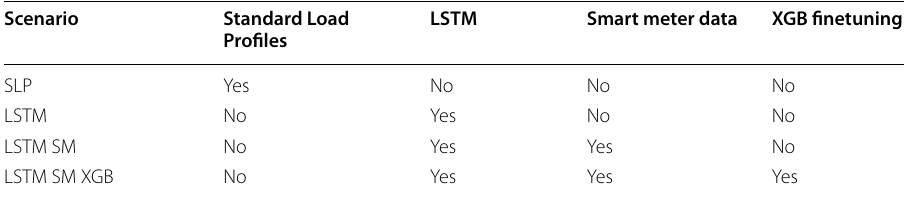
Table 7 Summary of included data and methods in evaluated scenarios